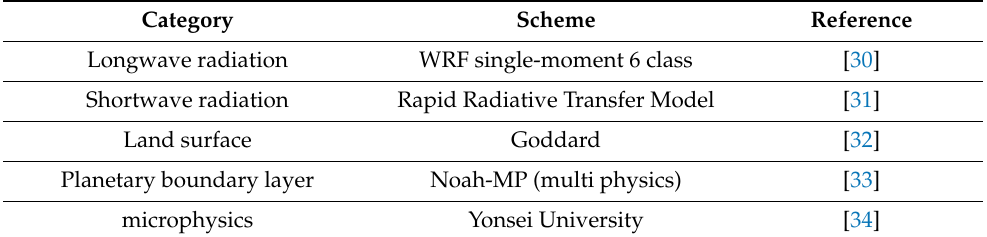
Table 1. The physics schemes used in the WRF configuration.